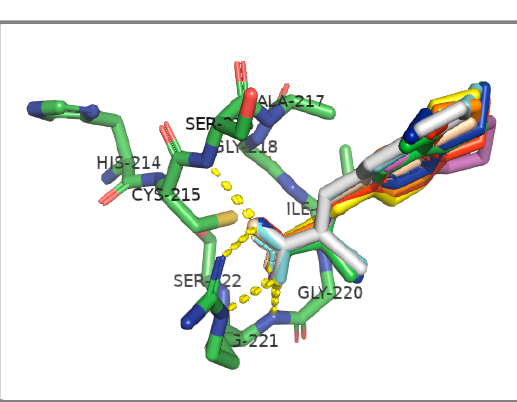
Figure 4. Molecular docking related PTP1B inhibition by 3,4-dimethoxy- β -nitrostyrene derivatives. Binding sites of compounds 1 , 2 , 3 , 4 , 5 , 6 , 7 , 8 , and 9 are represented by red, green, blue, yellow, magenta, cyan, orange, tint, and gray structures, respectively. The figure was generated using PyMol 2.0.